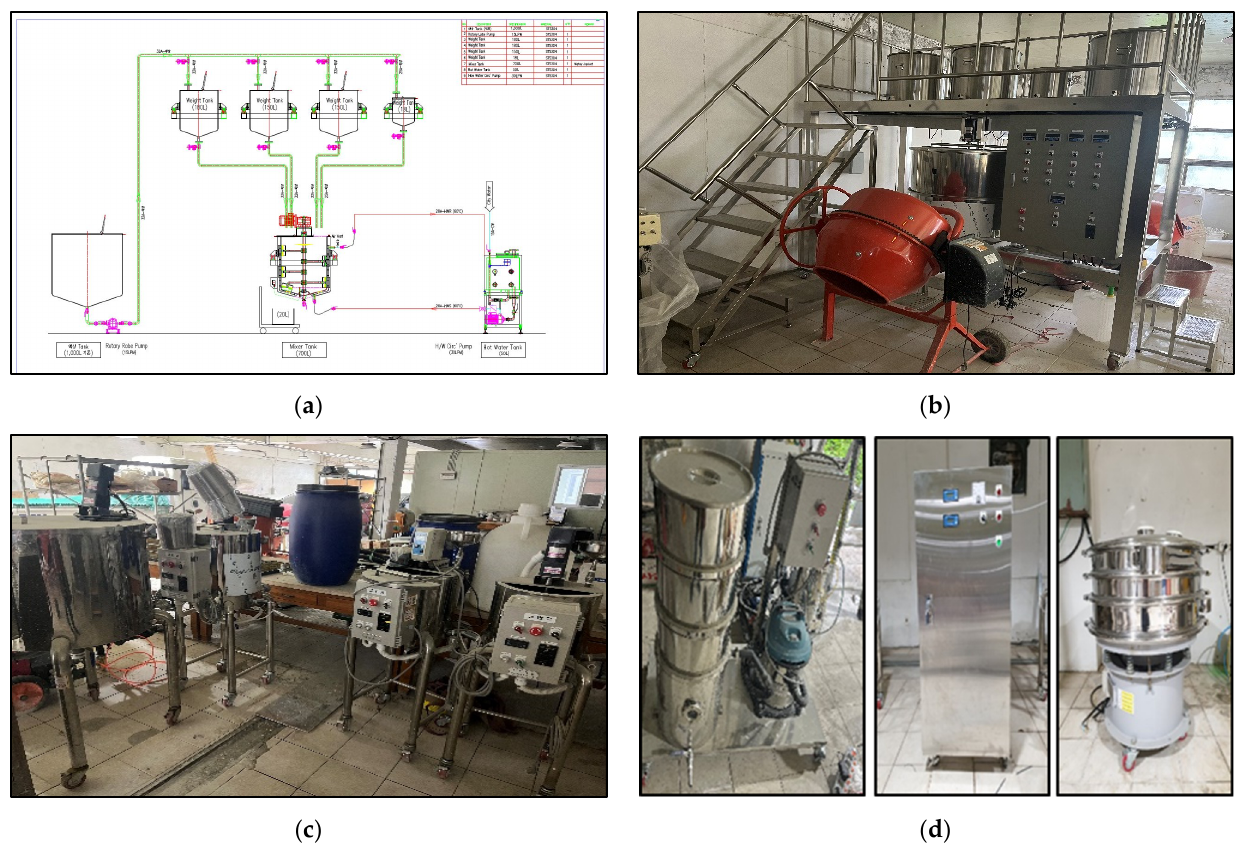
Figure 3. Encapsulation process of MCs: ( a ) original method; ( b ) improved method.